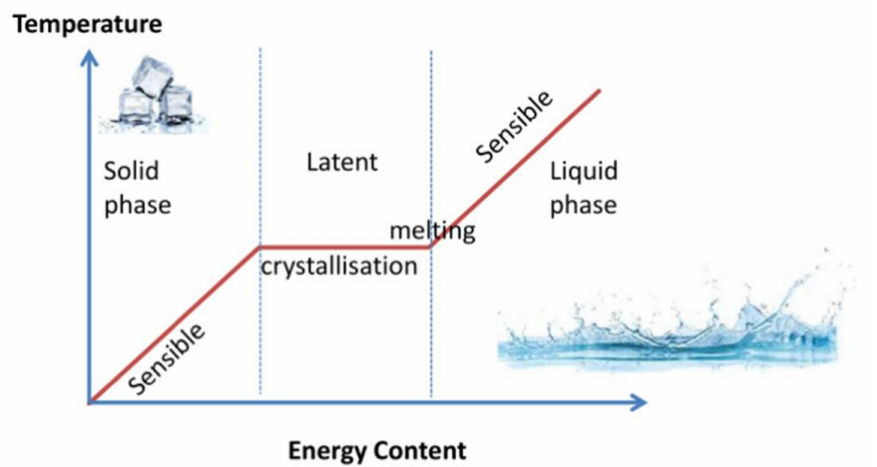
Figure 1. Basic principle of solid–liquid PCMs for energy storage. Reprinted with permission from ref. [18]. 28 September, 2021